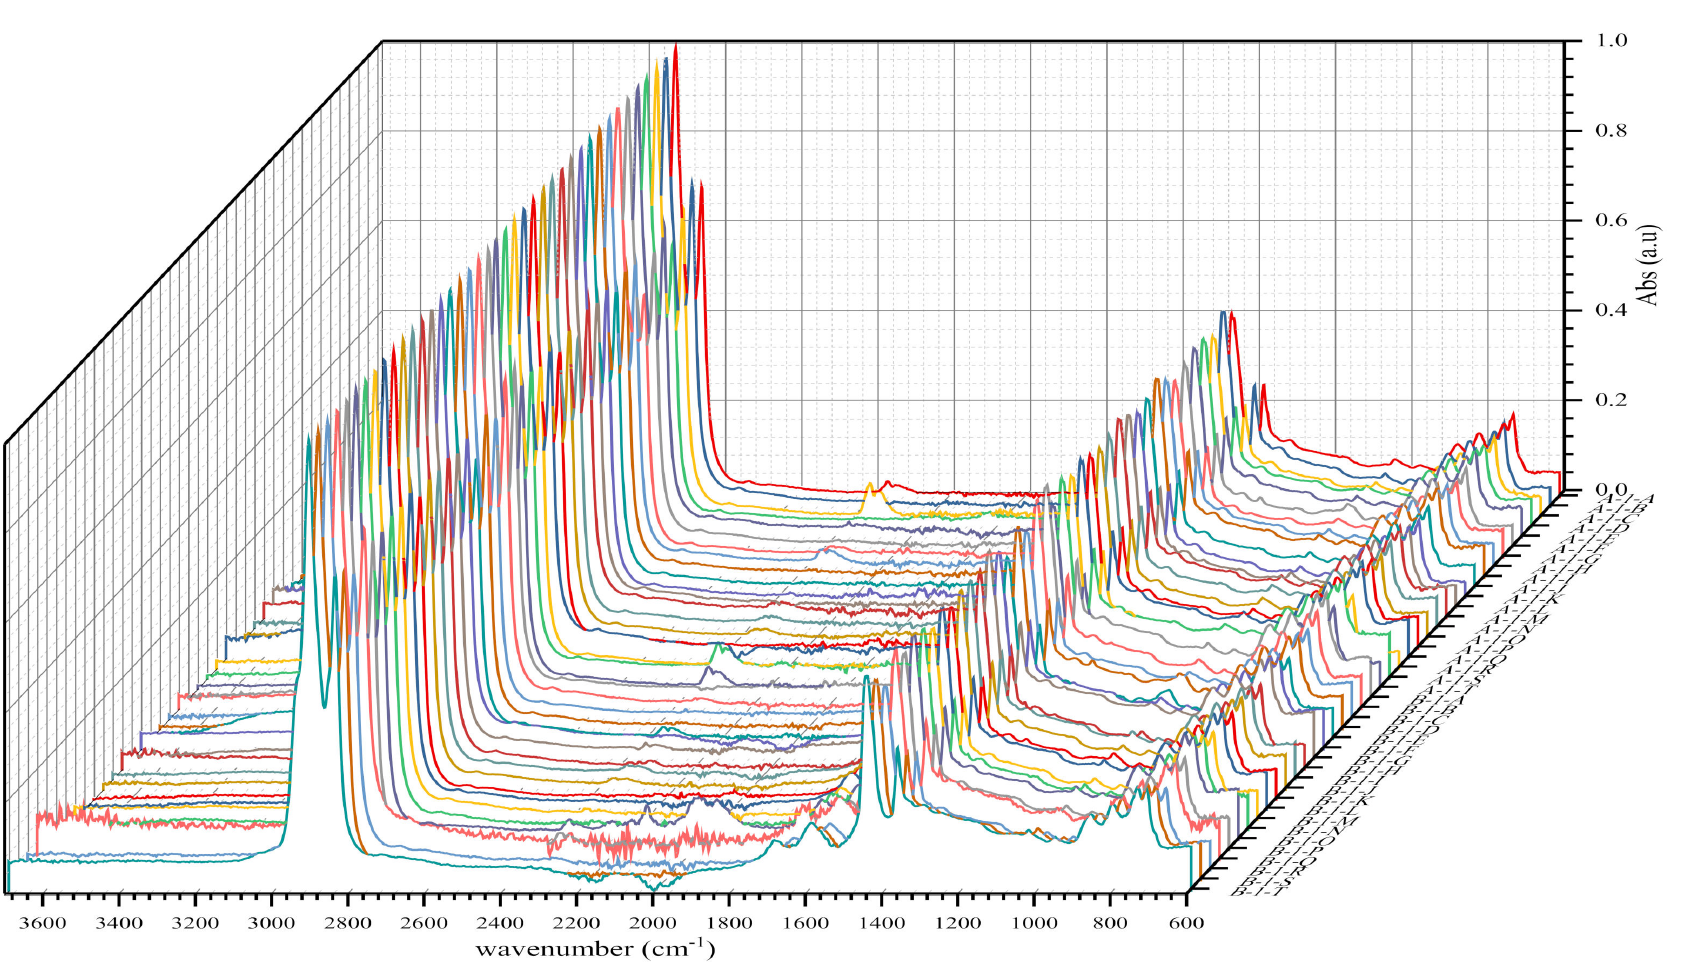
Figure 4. IR spectra of BND 70/100 from plants A and B before short-term ageing